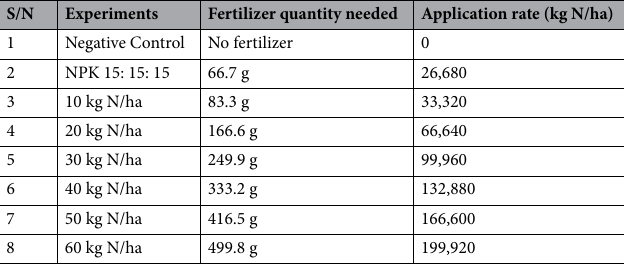
Table 1. Quantity of Carica papaya fruit peel organic fertilizer applied.